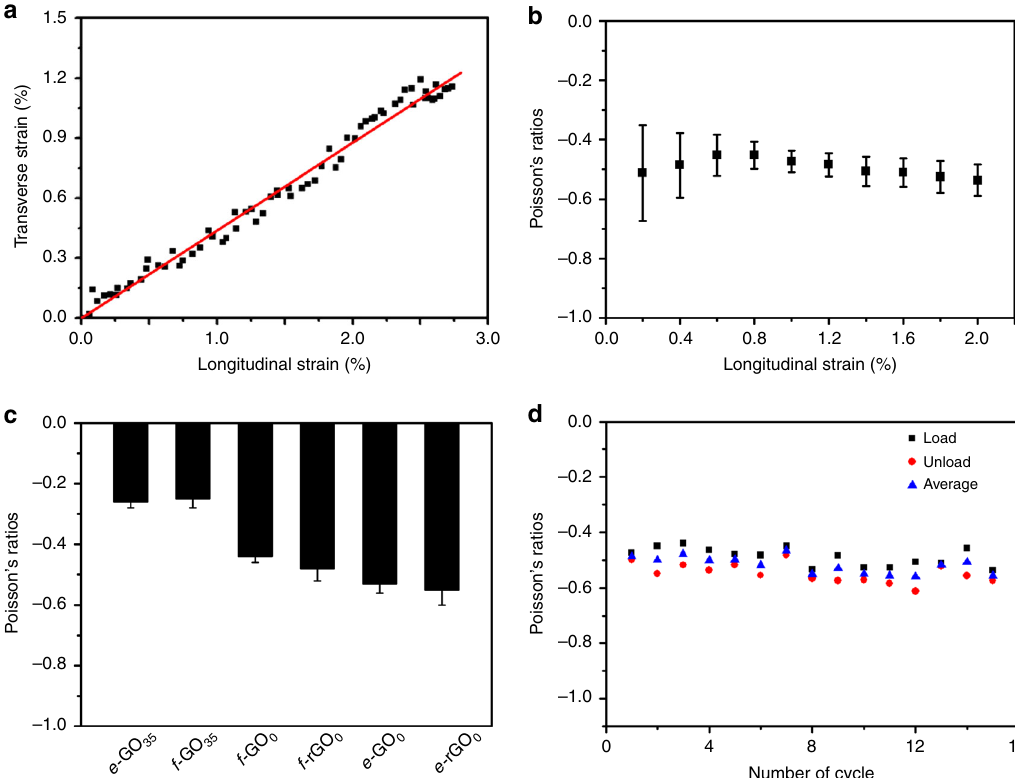
Fig. 2 Typical mechanical response of chemically modi fi ed graphene fi lms. a The transverse strain ε X plotted as a function of the longitudinal strain ε Y of e - GO 0 fi lms under a tensile loading in the Y direction. The red line is the linear fi tting line. b The instantaneous Poisson ’ s ratios of e -GO 0 fi lms averaged from three samples in Fig. S4b. c Poisson ’ s ratios of e -GO 35 fi lms (prepared by evaporation of GO solution synthesized at 35 °C), f -GO 35 (prepared by fi ltration of GO solution synthesized at 35 °C), f -GO 0 (prepared by fi ltration of GO solution synthesized at 0 °C), f -rGO 0 (reduced f -GO 0 fi lms), e -GO 0 and e -rGO 0 (reduced e -GO 0 fi lms). d Poisson ’ s ratios of e -GO 0 fi lms under cyclic uniaxial tensile loading with a peak strain of 1.5%. The error bars in panels ( b , c ) indicate the standard errors (three samples were measured). Source data are provided as a Source Data fi